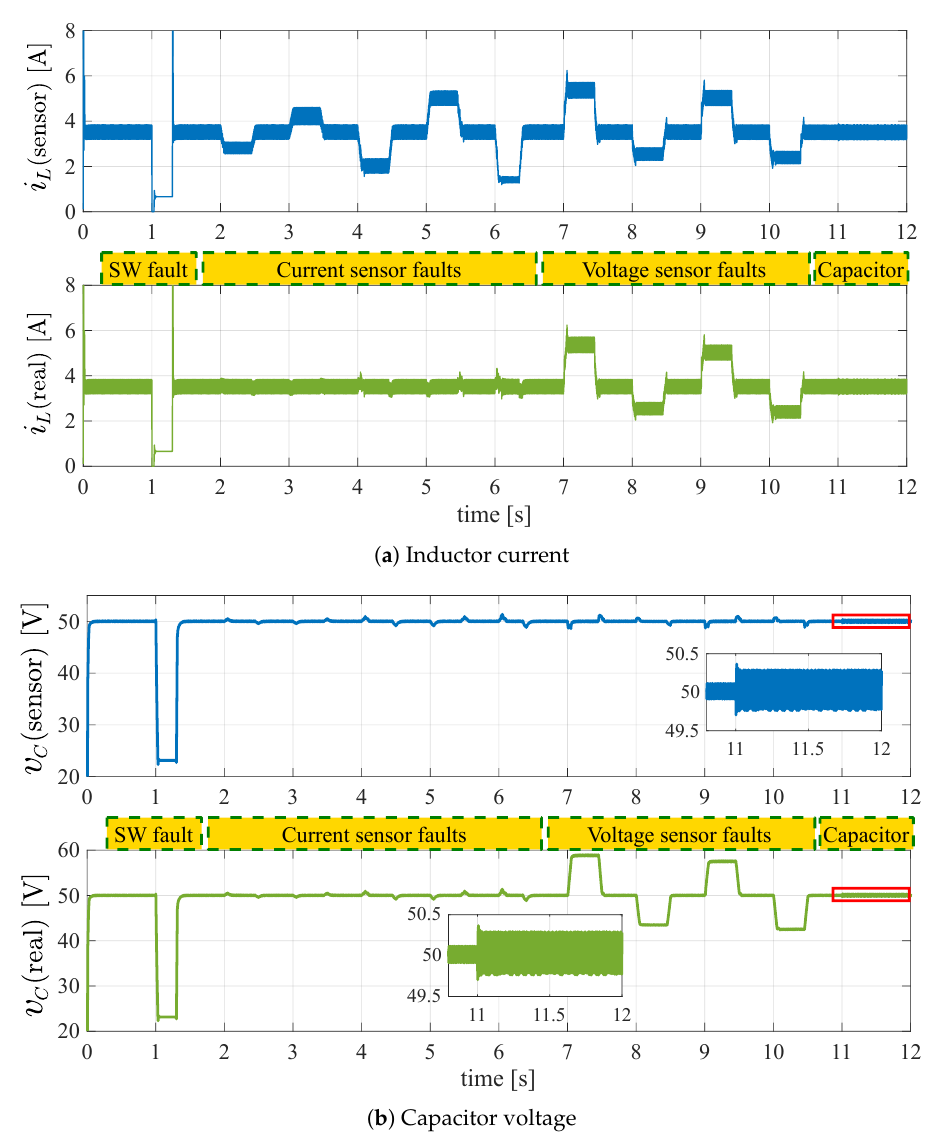
Figure 9. Boost converter simulation: real and measured states for R o = 35 Ω